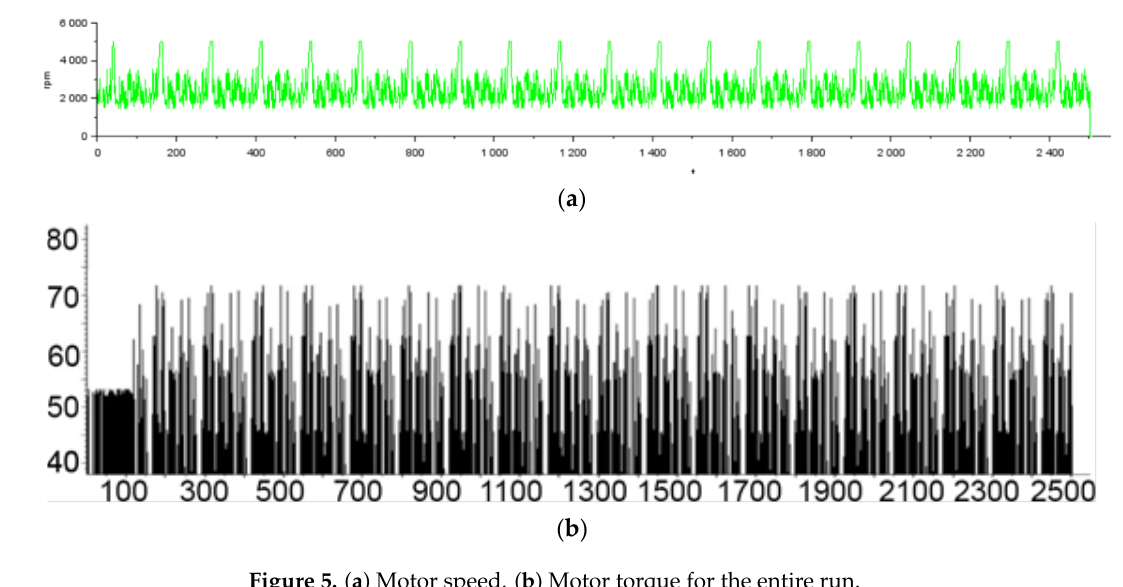
Figure 5. ( a ) Motor speed. ( b ) Motor torque for the entire run.